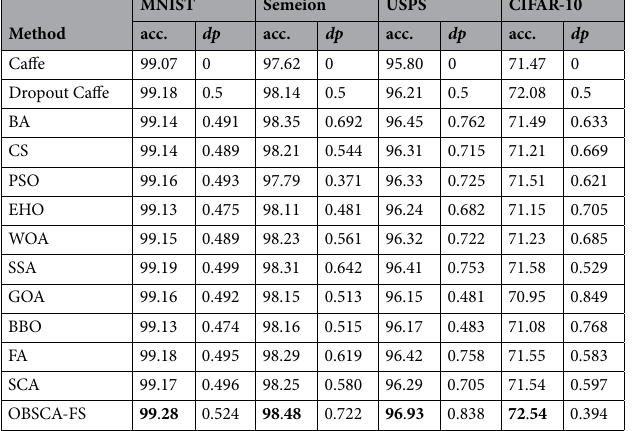
Table 9. Comparative results of the suggested OBSCA-FS method and other metaheuristics approaches in terms of mean classification accuracy.